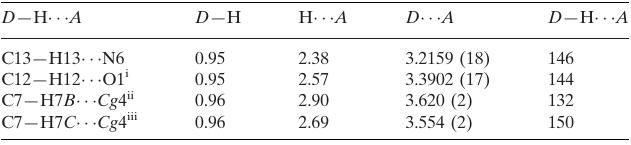
Hydrogen-bond geometry (A˚ , (cid:2)